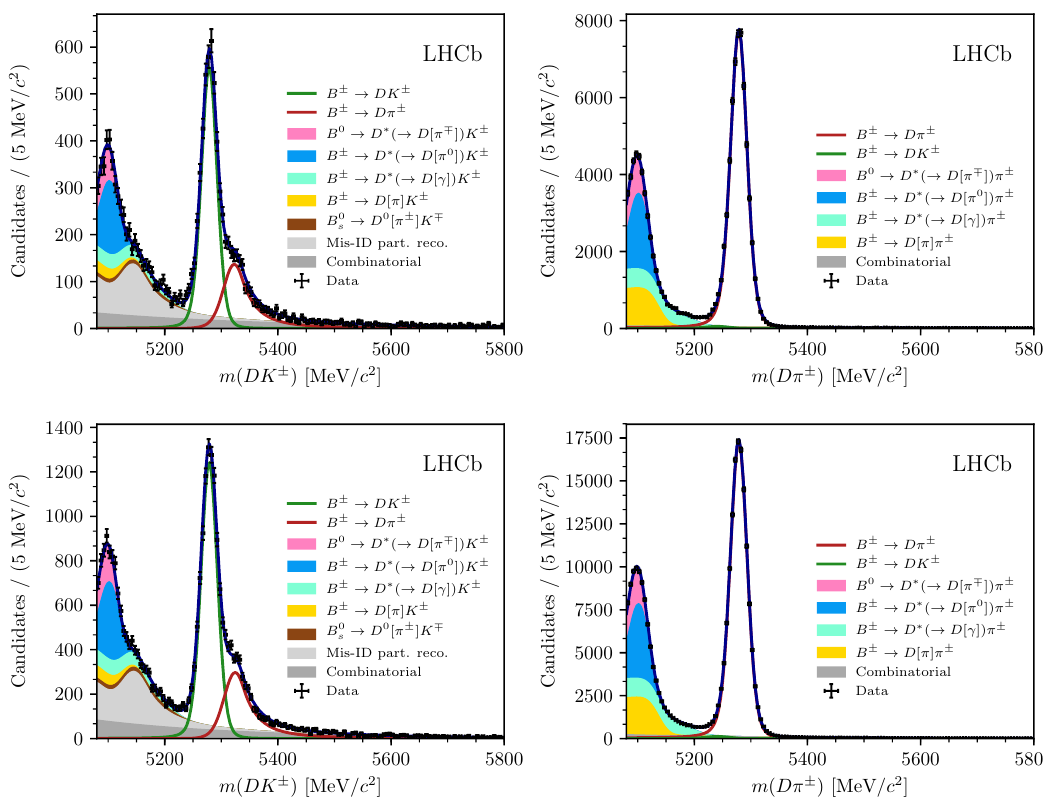
Figure 3 . Invariant mass distributions for the (left) B ± → DK ± channel and (right) B ± → Dπ ± channel with D → K 0 π + π − . The top (bottom) plots show data where the K 0 S ( downstream ). Square brackets in the legend denote a particle that has not been